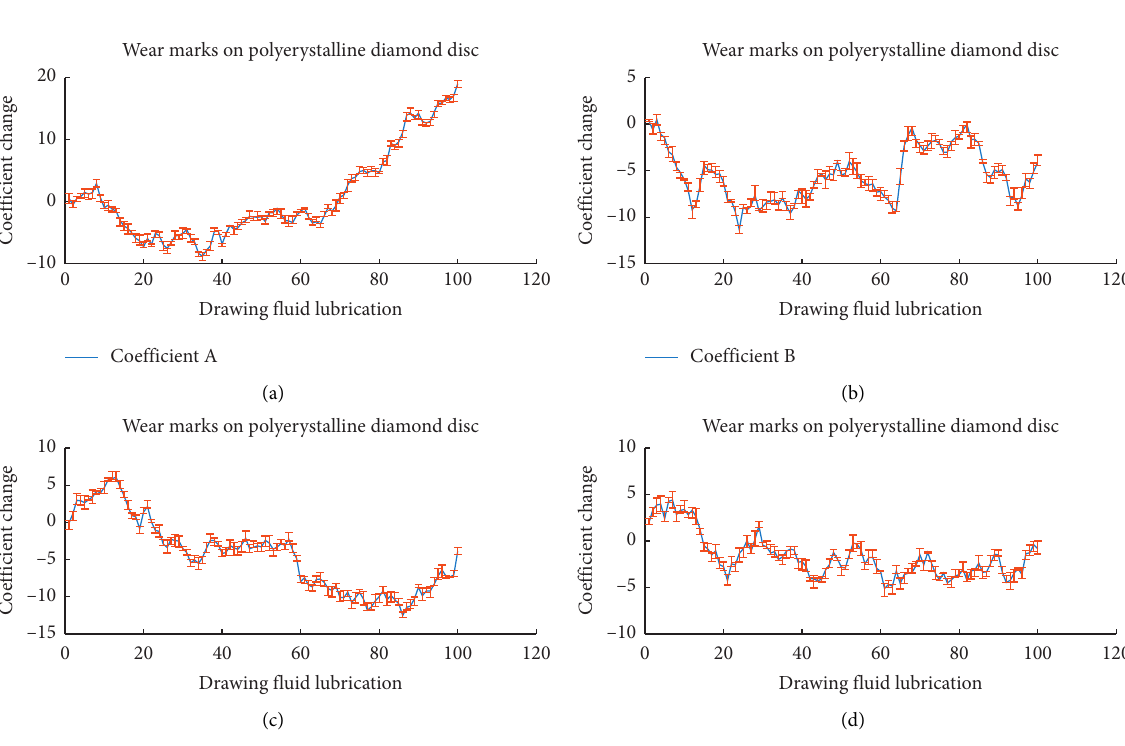
Figure 6: Ball surface lubricated with drawing